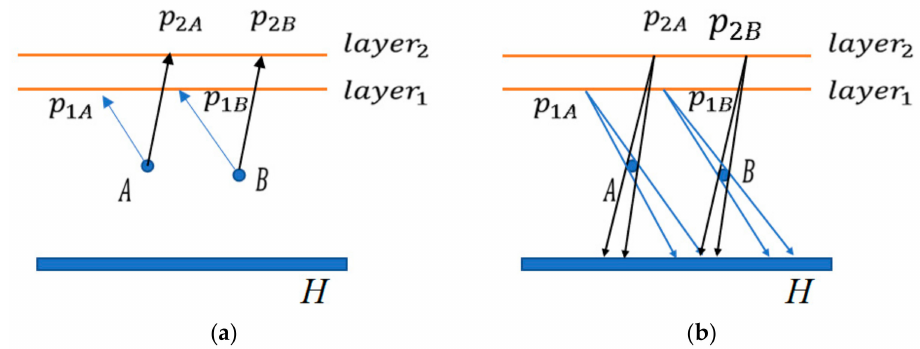
Figure 1. The concept of hologram calculation. ( a ) Projection of 3D object to di ff erent layers; ( b ) the calculation of complex amplitude on holographic plane H.